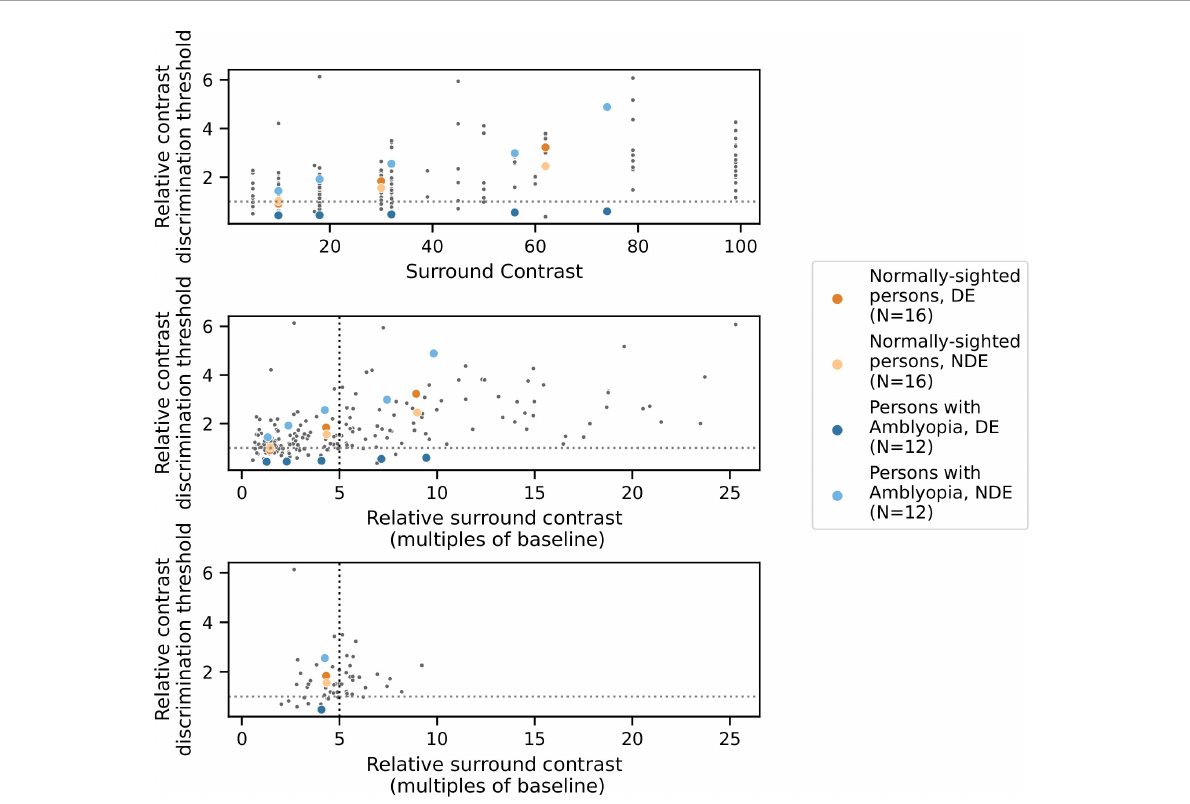
FIGURE3 Results from one example condition (iso-oriented surround, dichoptic presentation) illustrating the psychophysical modeling approach. Data points indicate relative contrast discrimination thresholds for each eye when the surround was presented to the other eye. Observations from one PWA (blue) and one NSP (orange) are shown in color. Top: Normalized contrast discrimination threshold (y-axis) vs. unnormalized surround contrast (x-axis, expressed as Michelson contrast values). The y-axis indicates contrast discrimination thresholds that were normalized by the baseline (no surround) contrast discrimination threshold for each eye and each participant. As a result of the normalization, each subject’s baseline values were rescaled to 1 for each eye and condition, and the horizontal line at y = 1 separates surround suppression ( > 1) from facilitation ( < 1). Middle: After normalization of surround contrasts. The x-axis represents the contrast of the surround as a multiple of the same baseline contrast discrimination threshold value used to normalize the contrast discrimination threshold values. The black vertical dotted line indicates the relative surround contrast value of five that we used to calculate a single relative contrast discrimination threshold value for each combination of eye, condition, and participant. Each of these thresholds was derived based on the relative surround contrast value that was closest to five. Bottom: The selected data points that were used for further